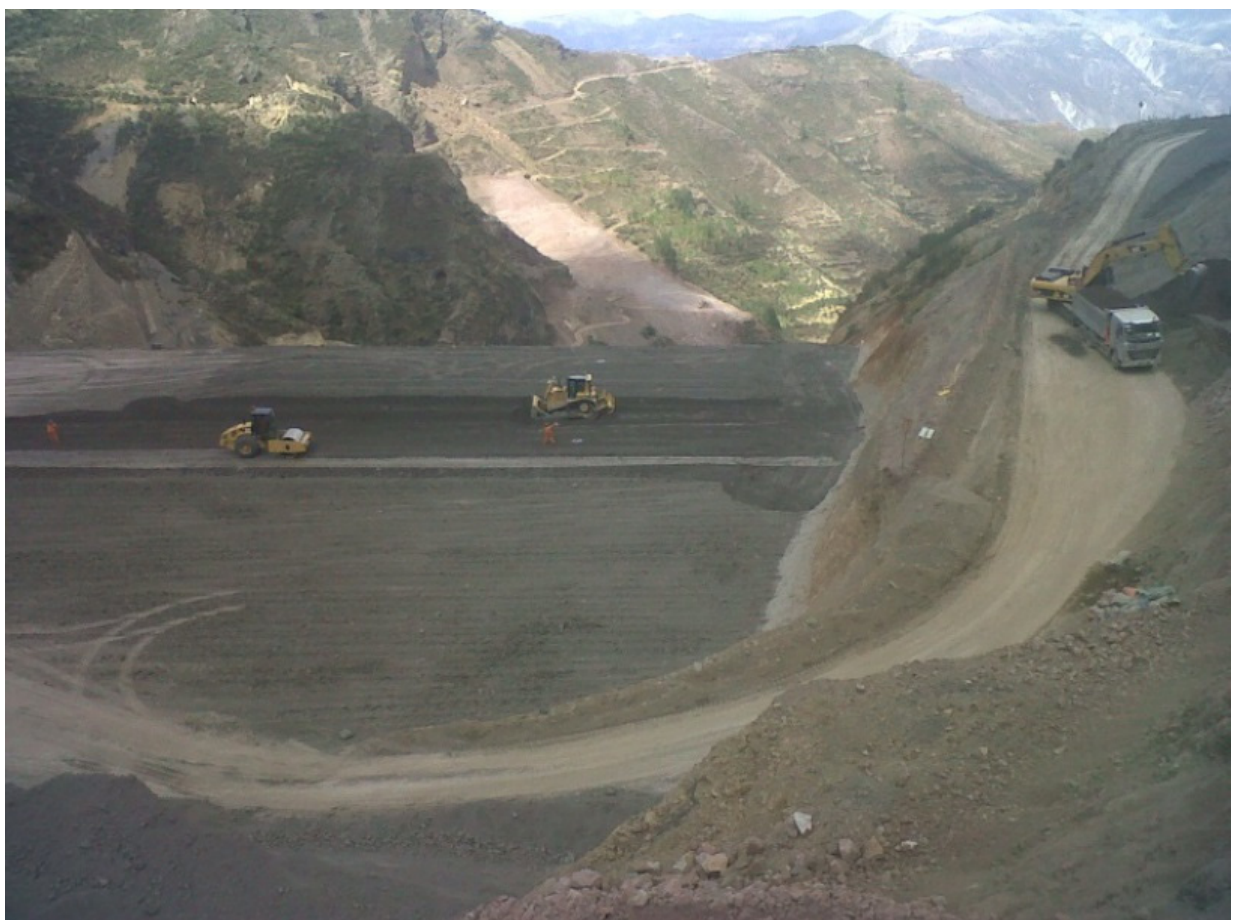
Figure 70. Ramahuayco TSF Civil Works [40,41].